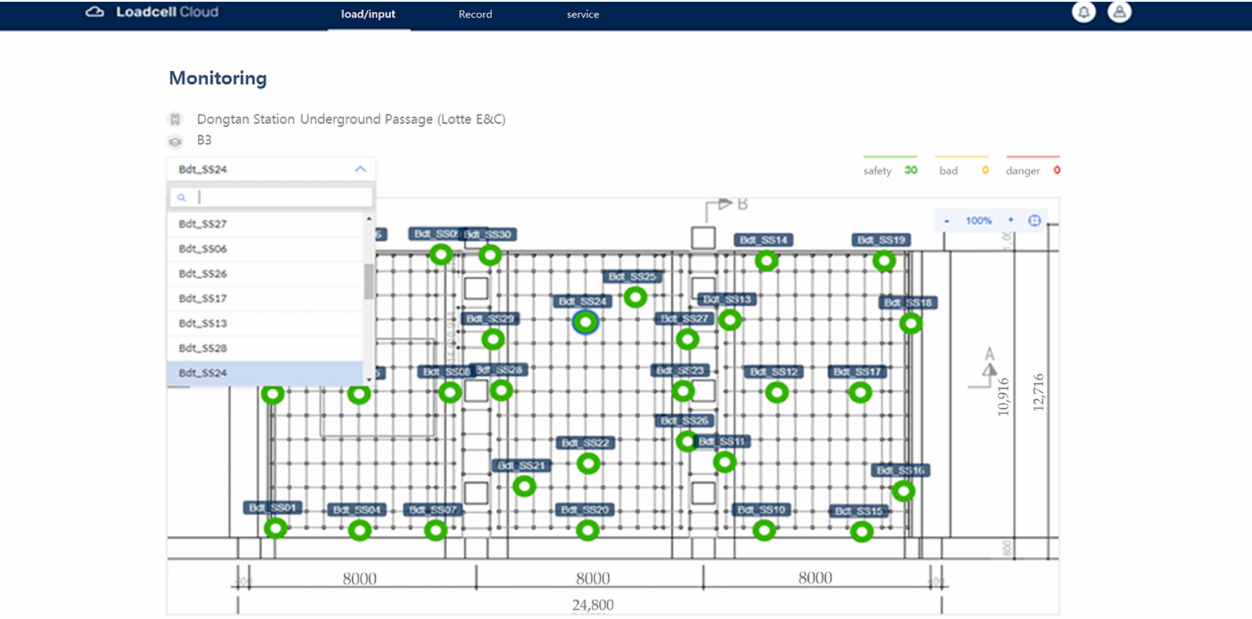
Figure 19. Setting the locations of devices using drag and